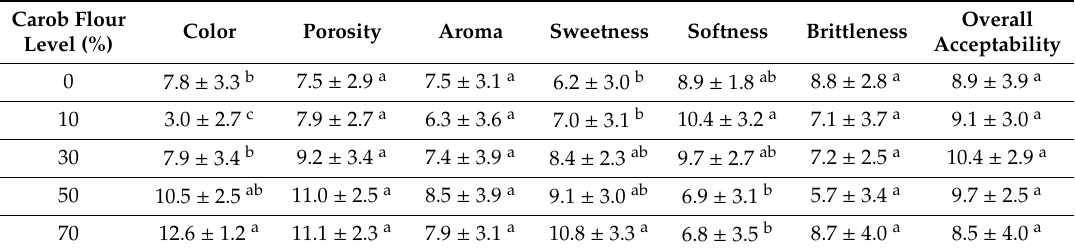
Table 3. Influence of the carob flour substitution level (0, 10, 30, 50 and 70%) on the sensory scores of di ff erent attributes assessed by panelists for the respective